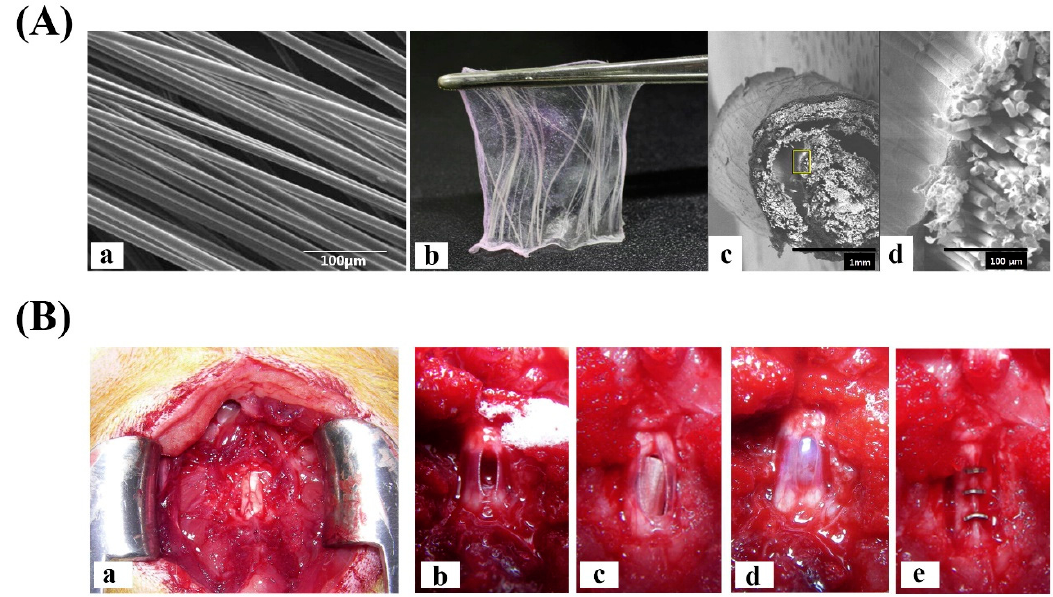
Figure 4. ( A ) Representation of (a) SEM images of fabricated phosphate glass fibers (PGFs); (b) PGF–collagen gel complex post dehydration process; (c) and (d) SEM micrograph of the PGF–collagen scaffold and magnified image of the yellow box in (c), respectively. ( B ) Images illustrating the surgical procedure for implantation of the scaffolds into completely transected rat spinal cords (a–e). Reproduced with some modifications from ref [76].